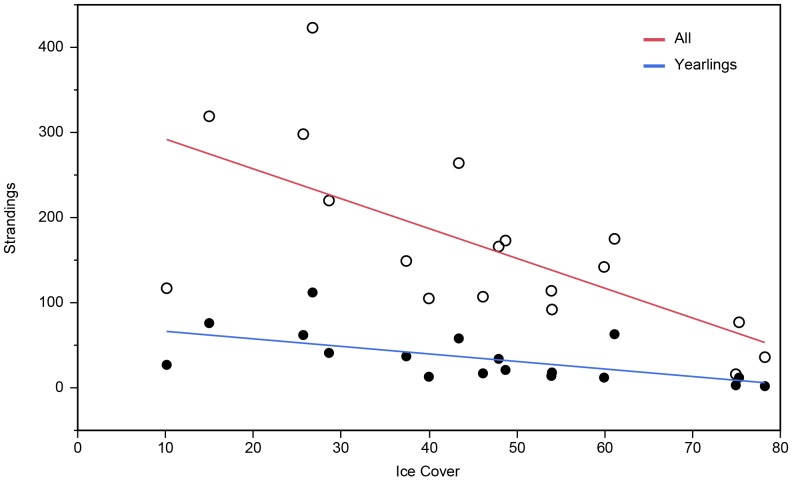
ANCOVA between linear regressions: percent sea ice cover vs. strandings (total and dead yearling strandings).The graph represents the ANCOVA between the linear regression of the present dataset (total strandings) and Johnston et al. [13](dead yearling strandings). Percent sea ice cover and total strandings (open circles and red line) and percent sea ice cover and dead yearling strandings (solid circles and blue line).